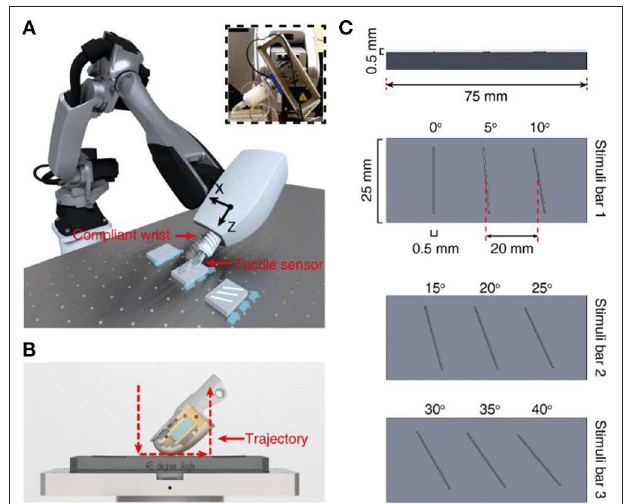
FIGURE 1 | Methods. (A) Robot setup with finger and compliant wrist integration. Insert demonstrates the integration of tactile sensor onto robot end effector with the help of a compliant wrist. (B) Illustration of the active touch protocol, where the finger is moved across the stimuli (red dotted line). (C) Representation of all the 9 ridge stimuli (3D printed with a height and width of 0.5 × 0.5mm, with placement of three